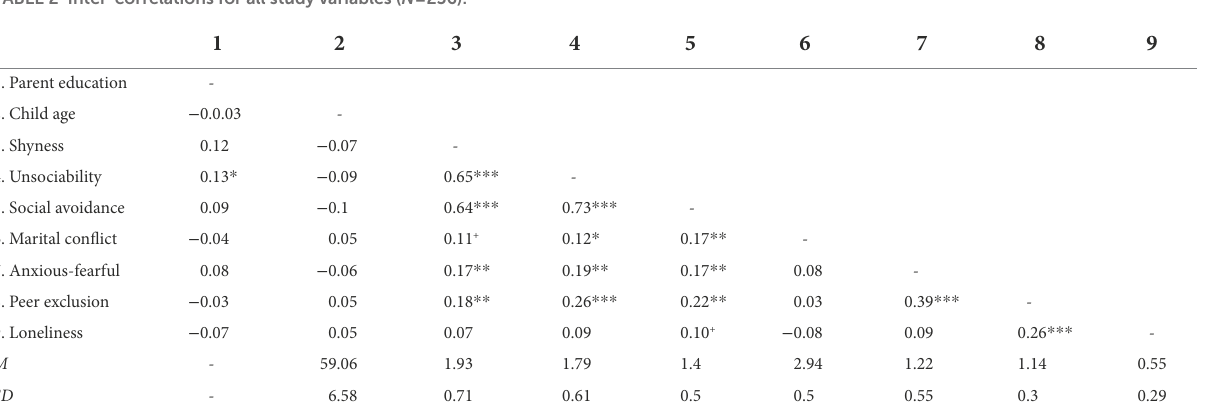
TABLE 2 Inter-correlations for all study variables ( N =